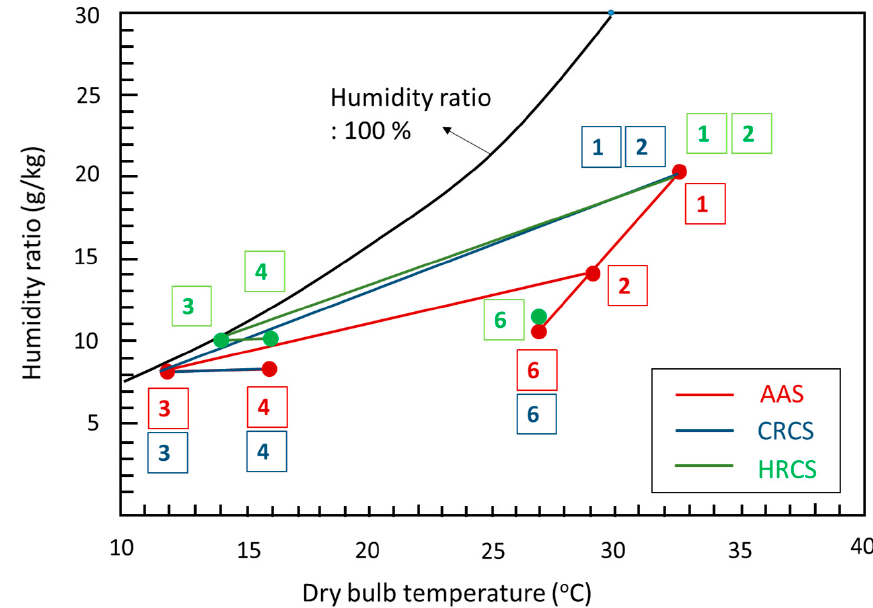
Figure 4. Psychrometric of the AAS, CRCS, and HRCS system .